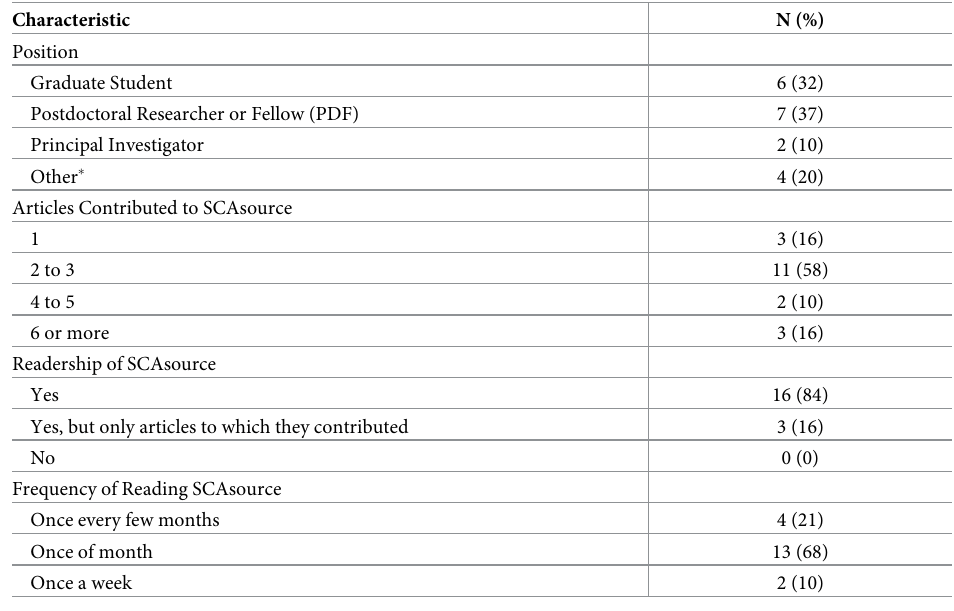
Table 1. Volunteer respondent